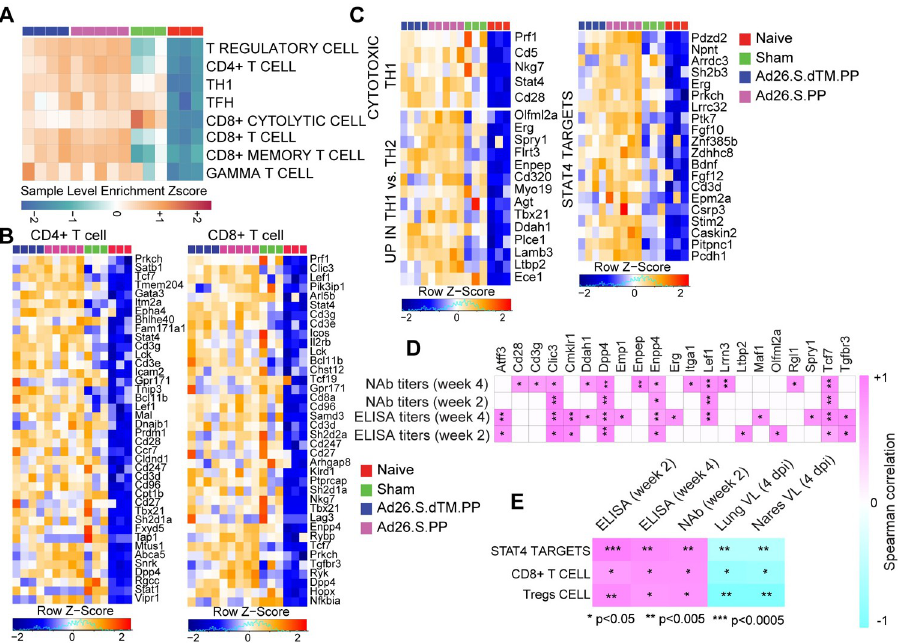
Fig 5. Ad26.COV2.S vaccination increased signatures of CD8+ and CD4+ T cell in vaccinated hamsters. (A) Sample-enrichment analysis (SLEA) of pathways of signatures of CD4, CD8, T regulatory cell (Tregs), T follicular helper cell (TFH) and T helper 1 (Th1) cell increased in vaccinated animals at 4 dpi (in pink and blue) compared to na ï ve and sham animals (in red and green). Heatmap presenting the SLEA z-score of each of these pathways. SLEA scores represent the mean expression of all significant genes within each pathway for each animal. An SLEA z-score greater than 0 corresponds to a pathway for which member genes are up-regulated, while an SLEA z-score inferior to 0 corresponds to a pathway with genes downregulated in that sample. Columns correspond to individual animals, and rows correspond to individual pathways scaled across all animals using the z-score R function. (B-C) Heatmaps of the leading genes of CD8+, CD4+, Tregs, and Th1 markers, increased at 4 dpi in vaccinated animals compared to na ï ve animals. Adjusted P-values ( < 0.05) were calculated by DEseq2 using Benjamini-Hochberg corrections of Wald test p- values. Columns correspond to individual animals, and rows correspond to individual genes normalized reads count scaled across all animals. (D-E) Matrix showing the Spearman correlations of CD4 T cell markers (D) and CD8 T cell signature, Tregs signature, and STAT4 targets (E) at 4 dpi with viral loads in hamster’s lung and nares, and with neutralizing and binding antibody titers at weeks 2–4 in vaccinated hamsters. Negative correlations were shown in cyan, and positive correlations were shown in